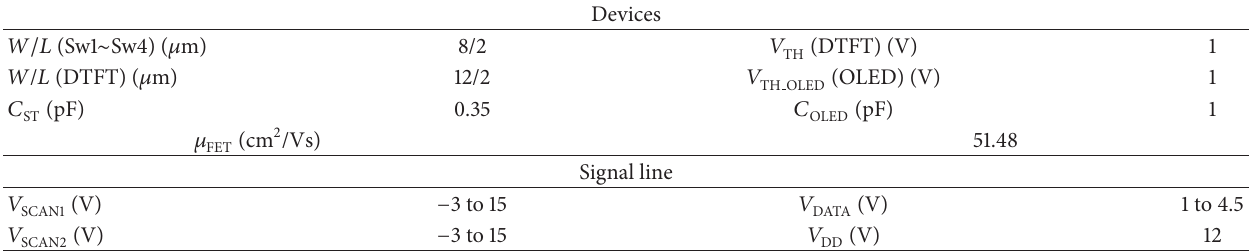
Table 1: Simulation parameters of the proposed pixel